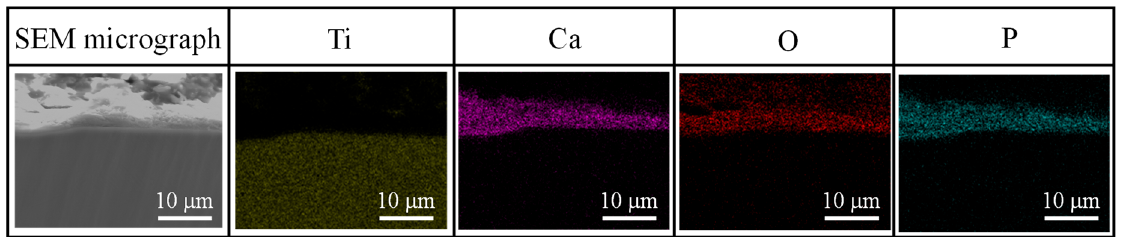
Figure 5. SEM micrographs and EDS maps for cross section of FPP-treated specimen.